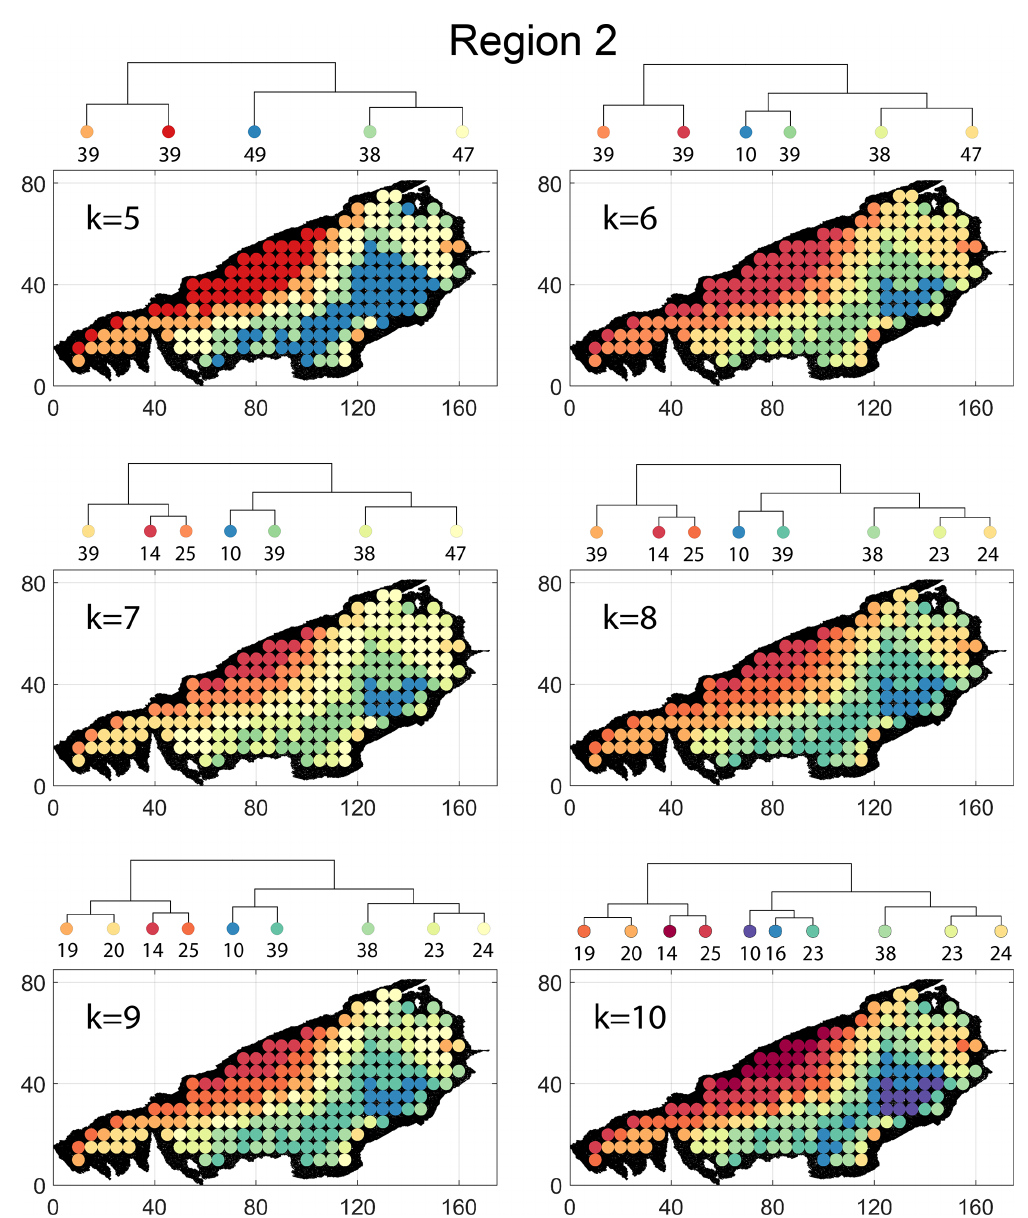
Figure B6. Variation in cluster boundaries for “ k ” clusters in Region 2 using